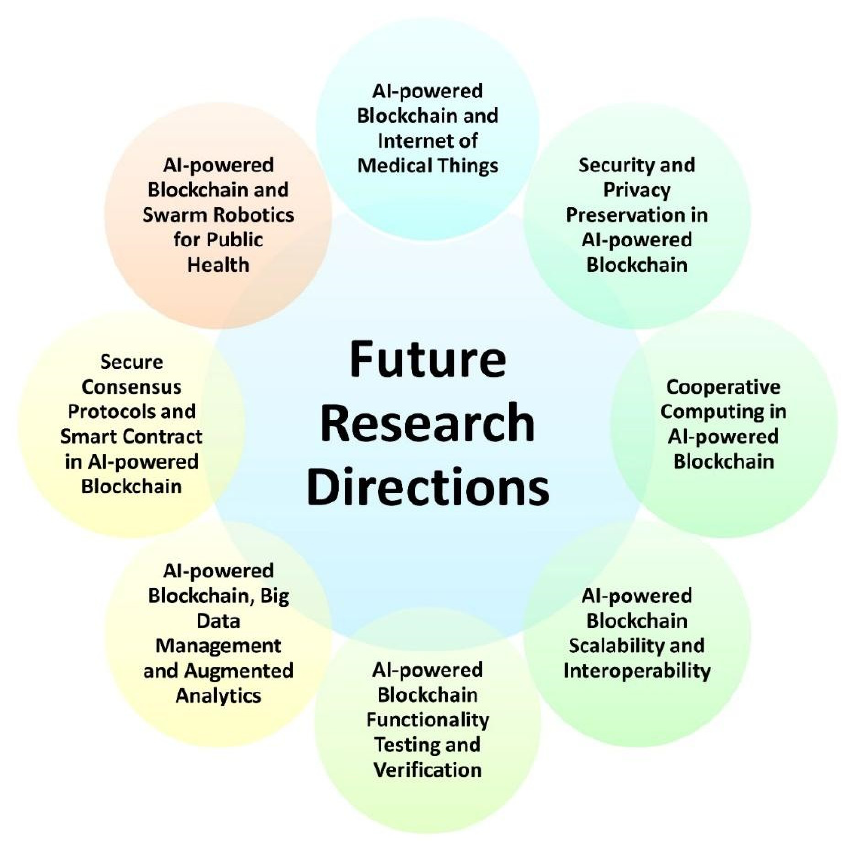
Figure 18. Future research directions for AI-powered Blockchain in public health.